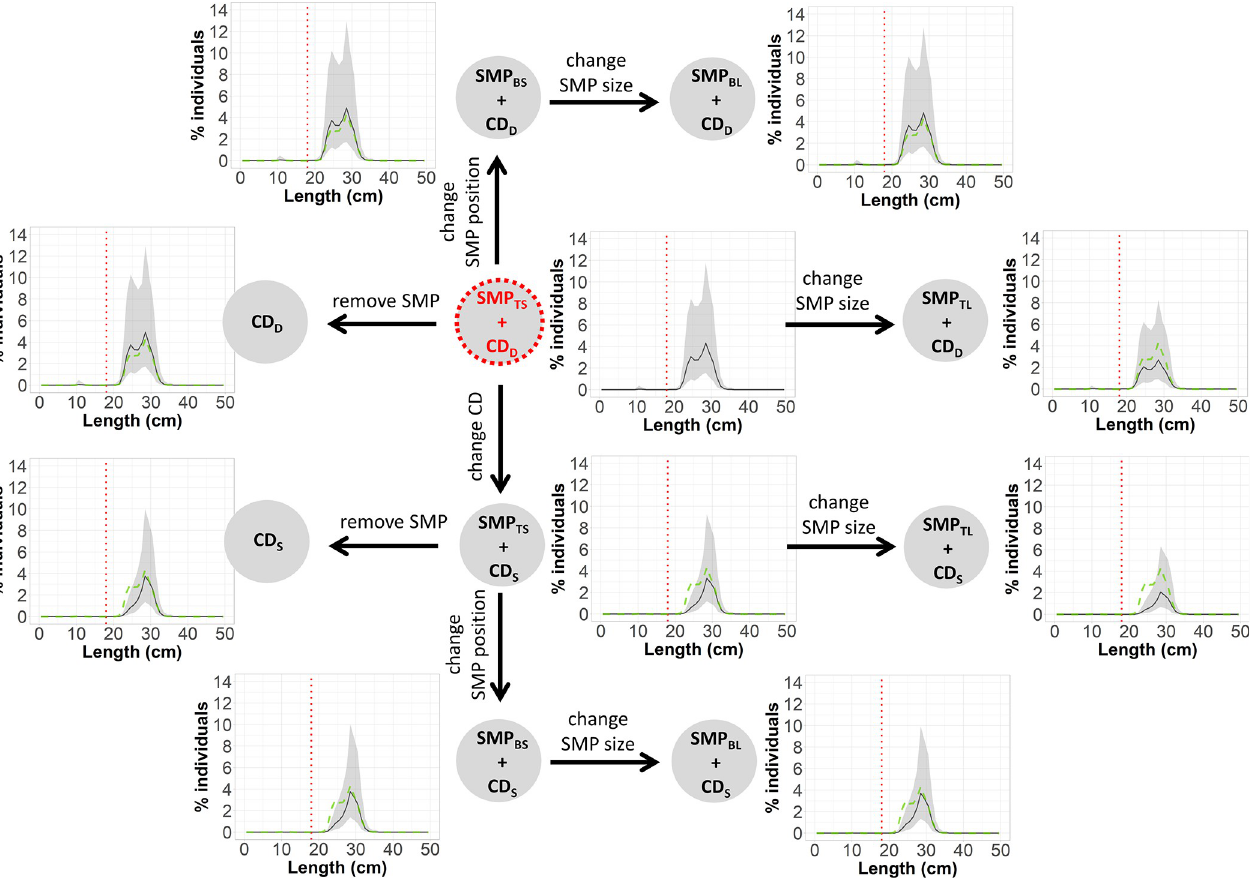
Fig 10. Treatment tree of the population structure fished for blue whiting with the different gear designs. Includes the fished population structure (black line) for each gear design and CIs (grey bands) and the population structure fished by the reference gear design (SMP TS + CD D ) (green dashed lines). Vertical red dotted lines correspond to the minimum marketable size: 18